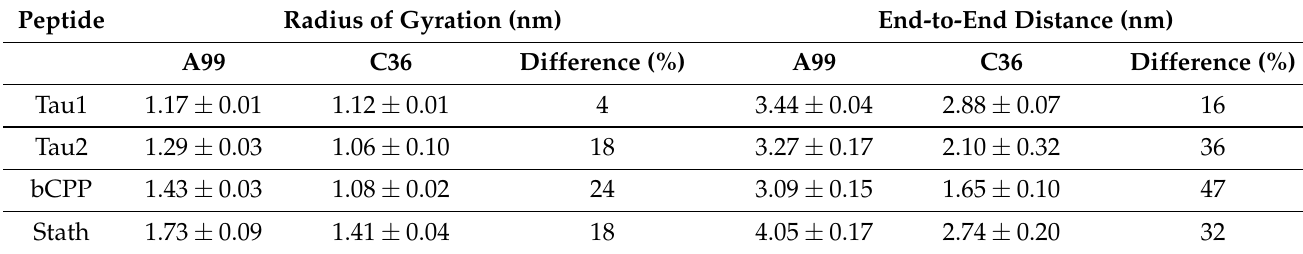
Figure 1. Distribution of the radius of gyration ( top row ) and the end-to-end distance ( bottom row ) of Tau1, Tau2, bCPP, and Stath simulated with Amber ff99SB-ILDN (A99) and CHARMM36m (C36). The legend applies to all panels. Table 2. Average radius of gyration and end-to-end distance of the peptides simulated with Amber ff99-SB-ILDN (A99) and CHARMM36m (C36). The difference between the force fields is expressed in relation to A99. Peptide Radius of Gyration (nm) End-to-End Distance